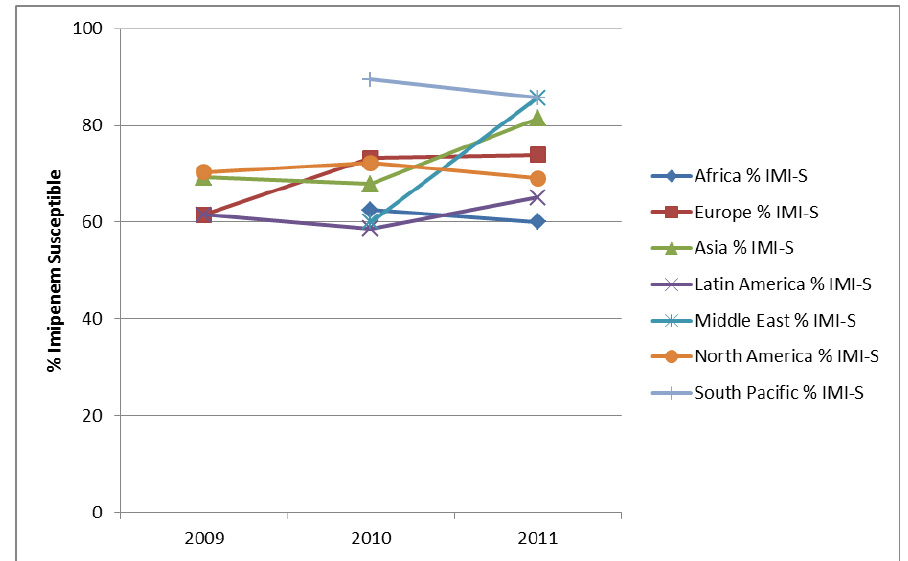
Figure 9. Susceptibility of P. aeruginosa from urinary-tract infections to imipenem (IMI-S) by region from SMART 2009 to